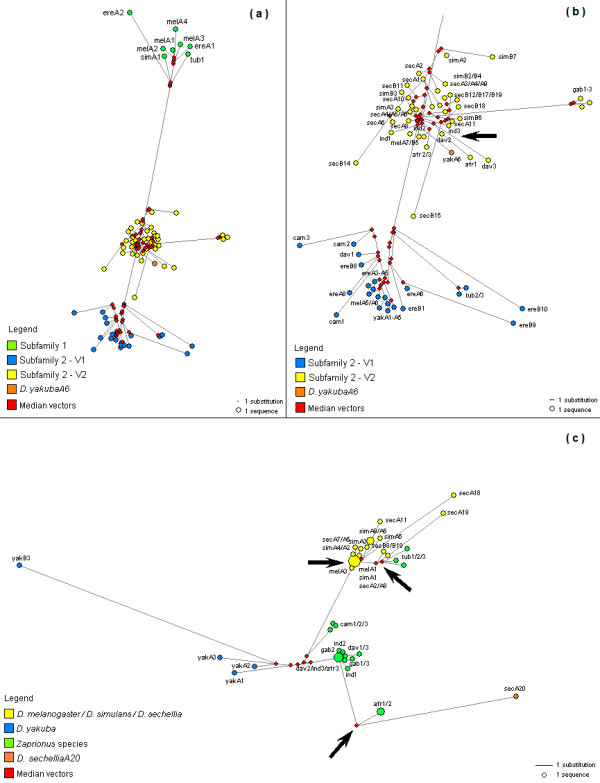
Network reconstructions. Median-joining network analyses for the Zaprionus and the melanogaster species. The size of each circle denotes the number of sequences grouped together. (a) Network for the Gypsy retroelement. Each group obtained in the phylogenetic tree is differently colored. (b) Detail of the Gypsy Subfamily 2. (c) Network for the Micropia retroelement. The sequences are colored according the clustering in the phylogenetic tree. The black arrows show the HT events evidenced by network trees.